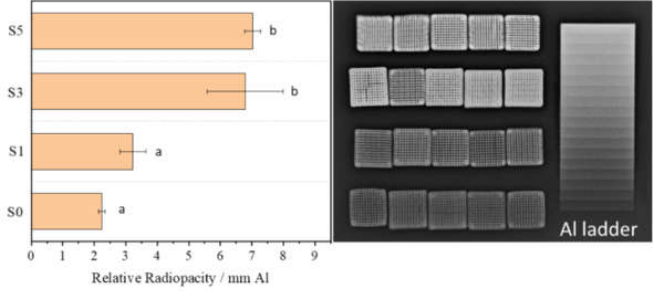
Figure 6. Relative radiopacity of MgNH 4 PO 4 ·H 2 O/SrHPO 4 porous composite scaffolds calculated by image analysis with respect to an aluminum standard. Different small letters represent statistically significant differences ( p < 0.05), whereas the same small letters represent non-statistically significant differences ( p > 0.05).